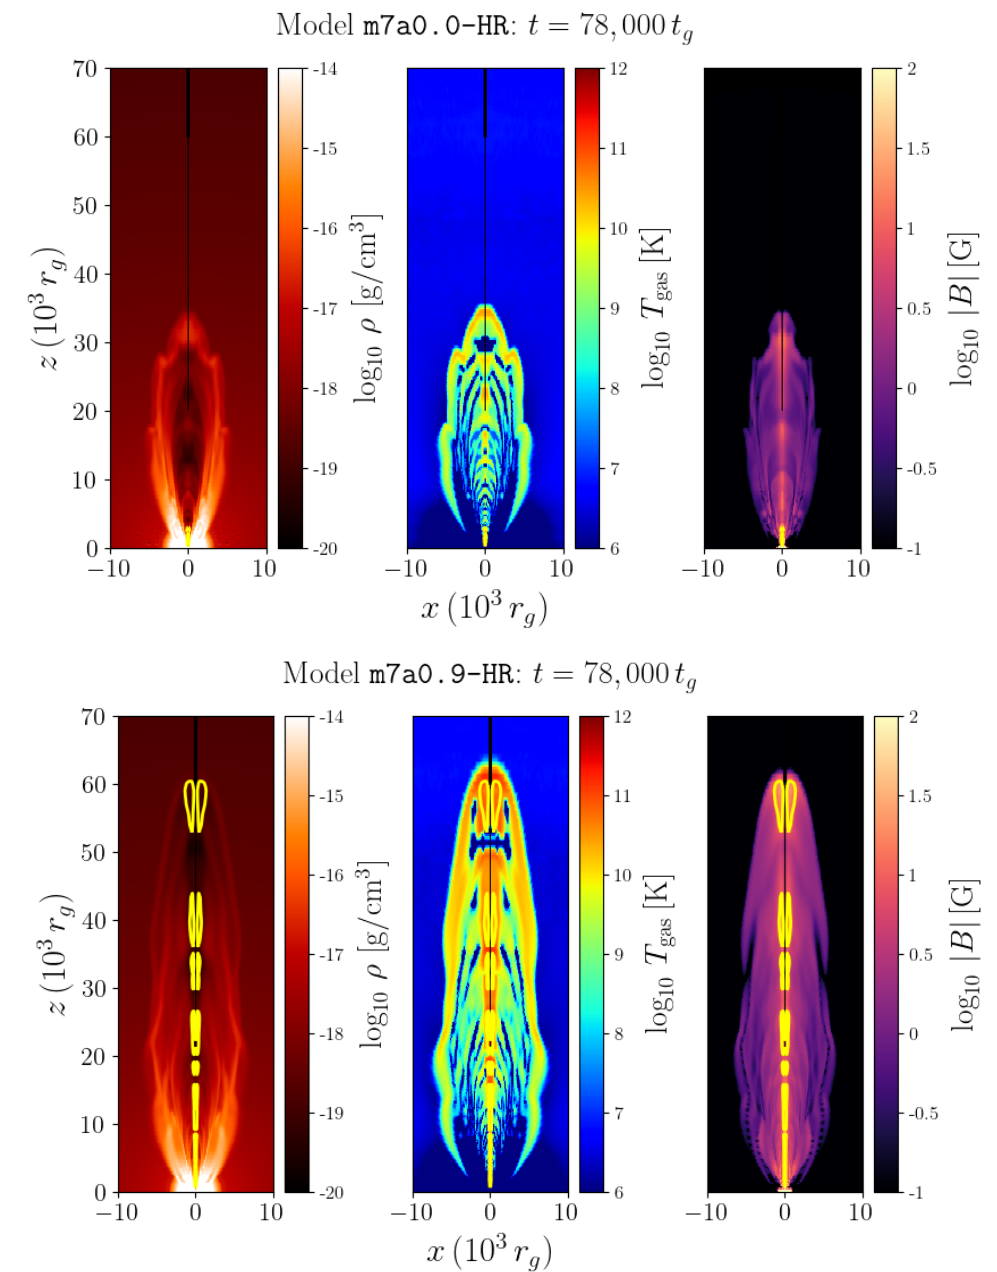
Figure 1. Here we show snapshots of the GRRMHD KORAL simulations that we post-processed with ipole. All data are shown for t = 78,000 t g in both m7a0.0-HR ( top ) and m7a0.9-HR ( bottom ). The colors indicate the gas density ρ ( left ), gas temperature T gas ( middle ), and magnetic field strength | B | ( right ); the yellow contours indicate the σ = 1 boundary, in which we set ρ = 0 in the ray tracing step to prevent